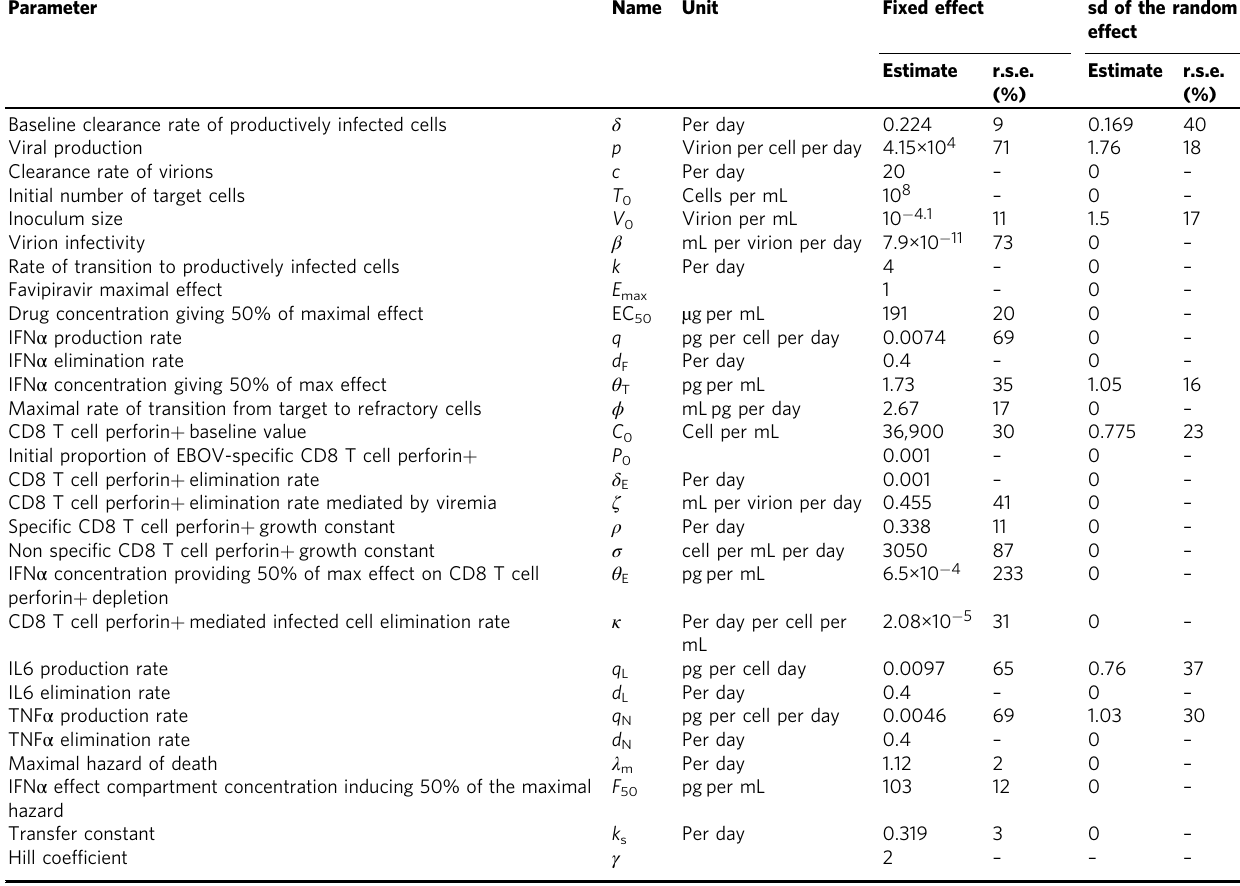
Table 1 Parameter estimates of the fi nal viro-immunologic model of Ebola virus disease in cynomolgus macaques